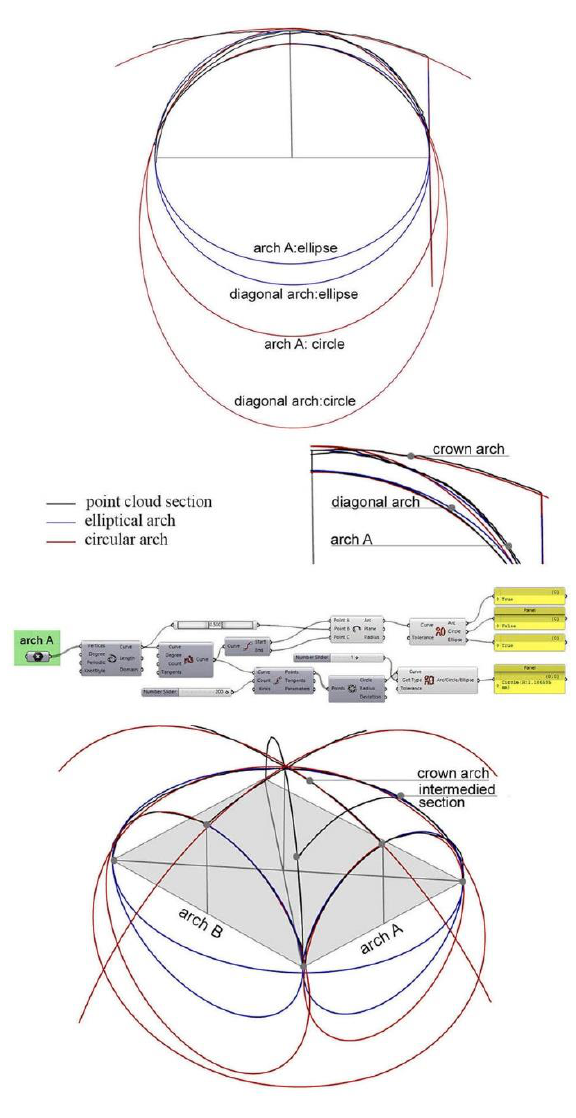
Figure 4. Visual scripting best fit arches: circles or